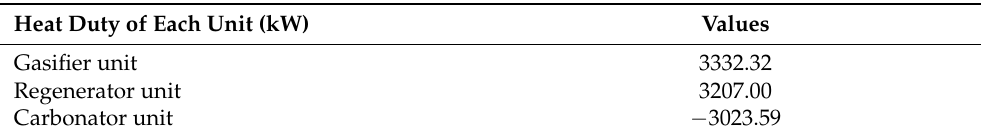
Table 8. The heat duty of each unit in the co-gasification of biomass and coal integrated with the calcium looping carbon dioxide capture process.